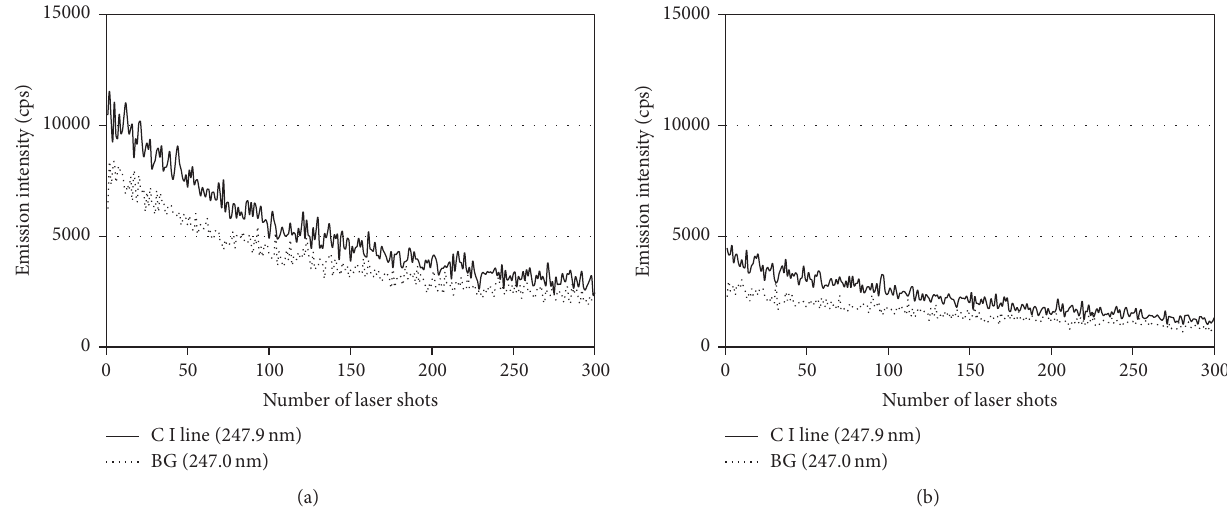
Figure 7: Emission signals from both C (247.9 nm) and background (247.0nm) observed for Ti under (a) Ar and (b) He chamber gas conditions as a function of laser